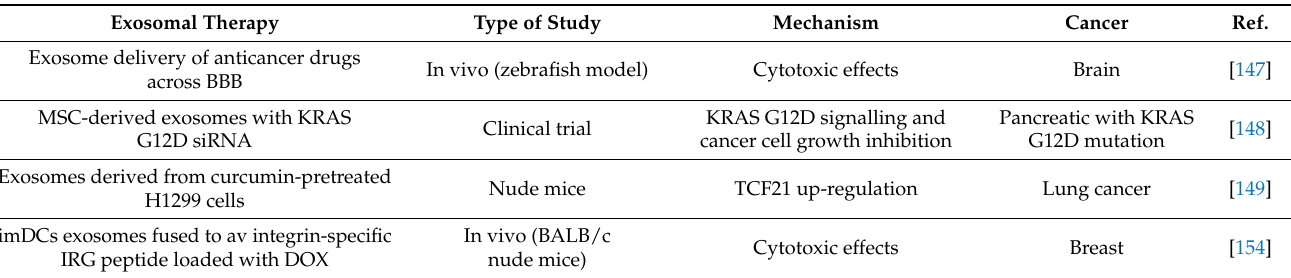
Table 2. Some in vivo experimental studies and clinical trials for exosomal cancer therapy. Exosomal Therapy Type of Study